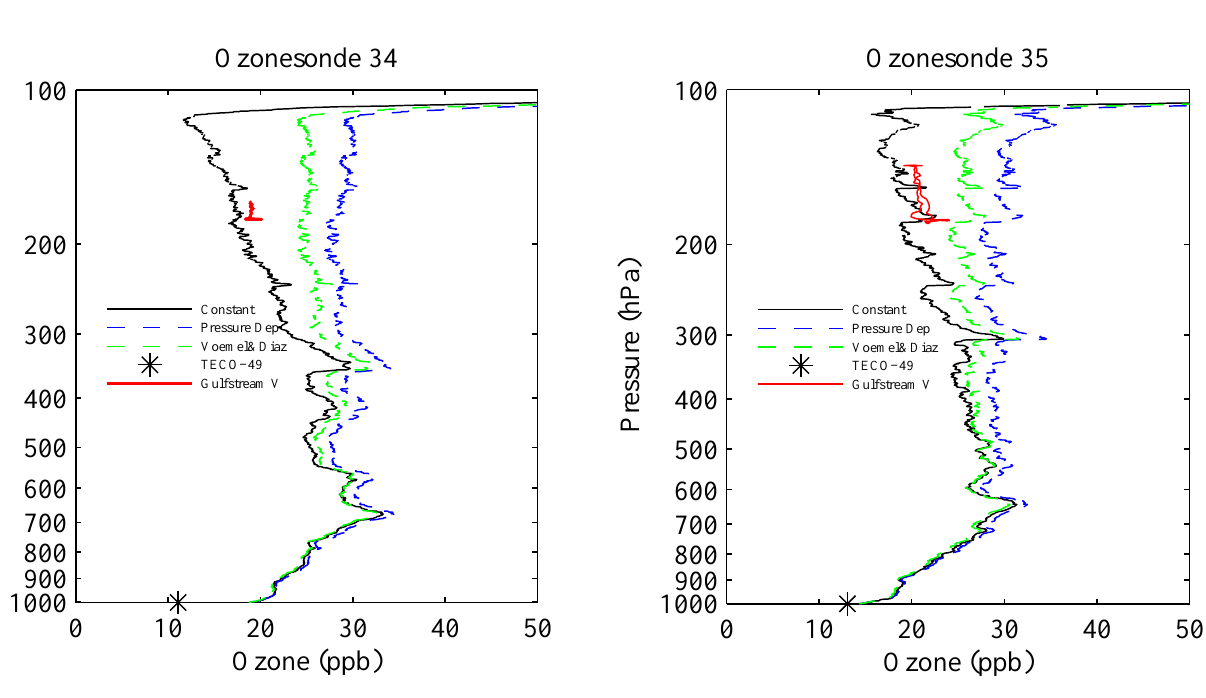
Figure 6. As Fig. 4 for CAST ozonesonde 35 and inbound leg of Gulfstream V flight RF14 on 22